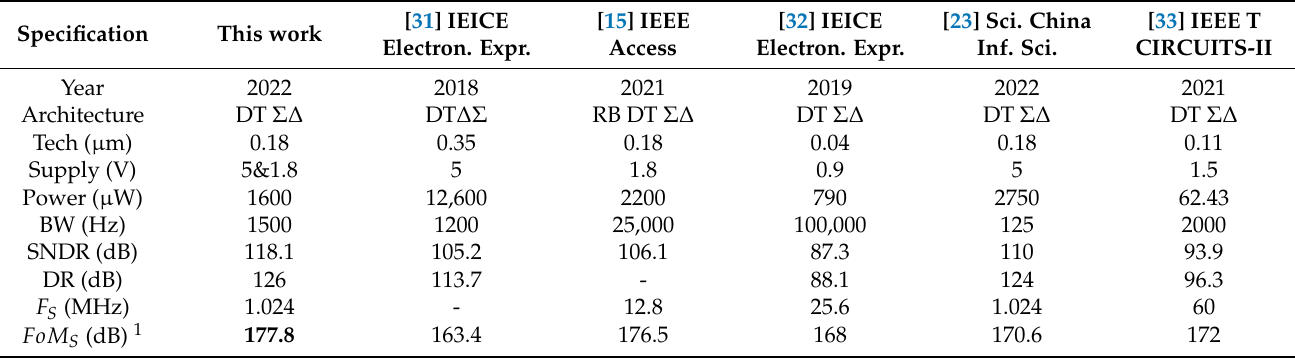
Table 2. performance summary and comparison with previous